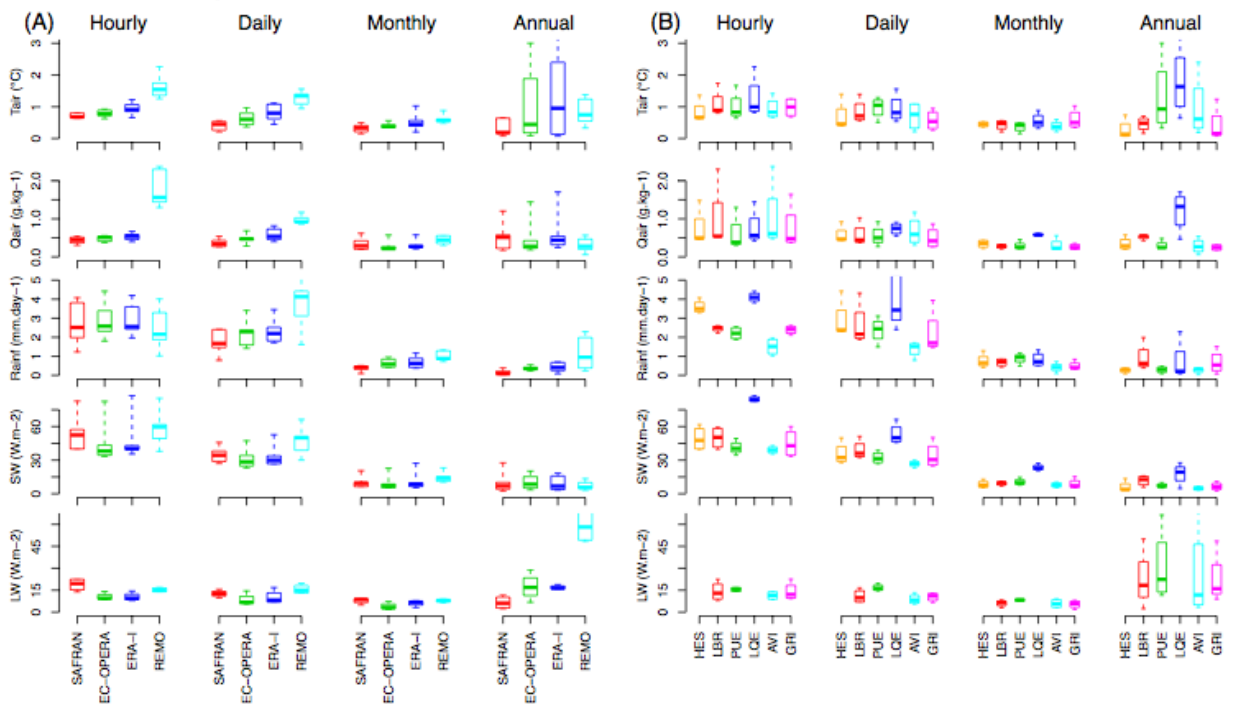
Figure 4 128 Fig. 4. Mean absolute error (MAE) between meteorological gridded data and in situ data (LOCAL) over 2004–2007, except for EC-OPERA which covers only 2004–2006. Time series used to calculate MAE correspond to growing season except for at the annual time scale, which covers continuously from 1997 to 2007, whenever data is